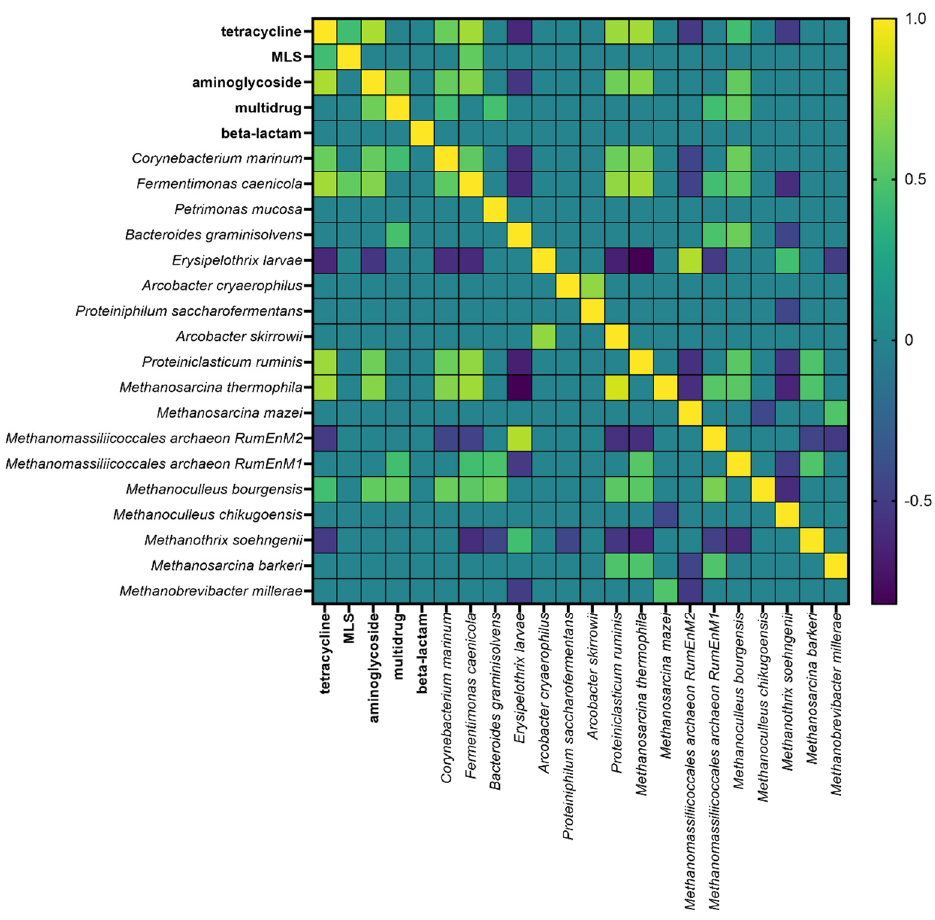
Figure 6. Spearman’s rank order correlation coefficients for the relationships between microbial abundance and the abundance of different ARG types.